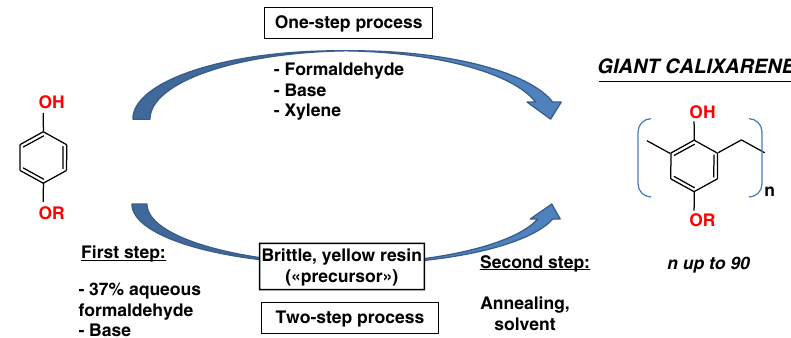
Fig. 1 The two base-catalyzed processes used for giant calixarenes synthesis. The conditions used are summarized on the